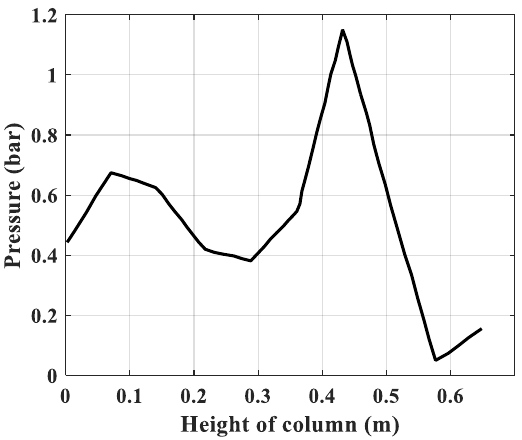
Figure 8. The result of partial pressure (O 2 ) following height of column at 5.5 bar.